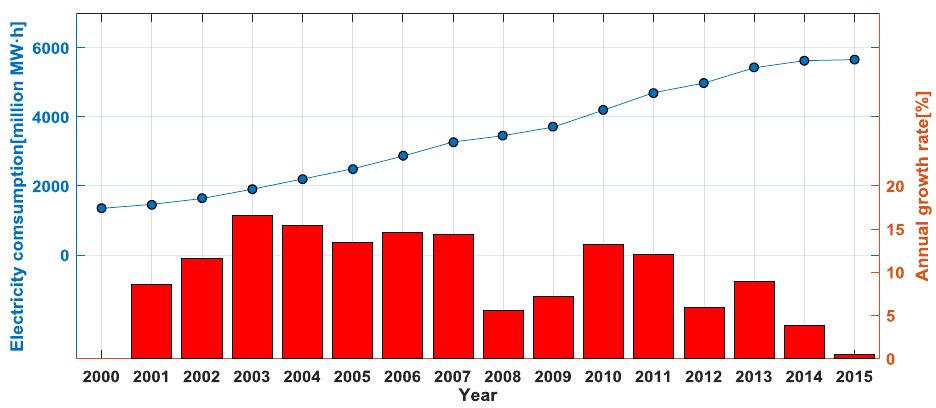
Figure 1. Annual electricity consumption variation tendency of China in 2000–2015.